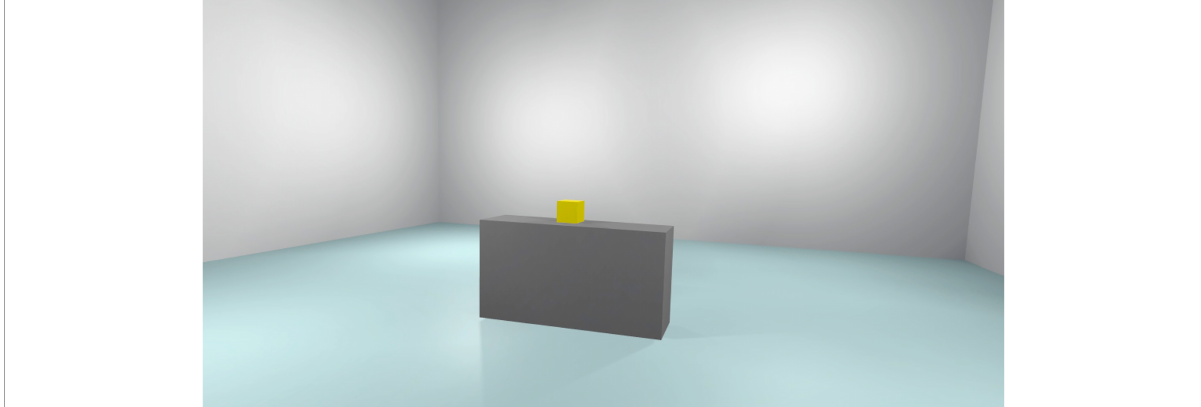
FIGURE2 Tutorial scenario.